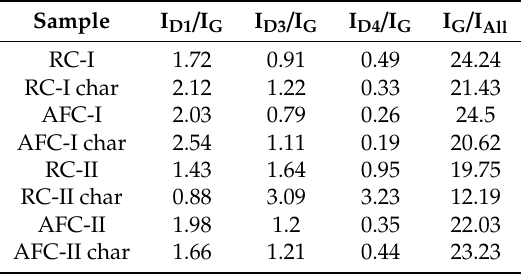
Table 4. I D1 / I G , I D3 / I G , I D4 / I G and I G / I All of each sample.